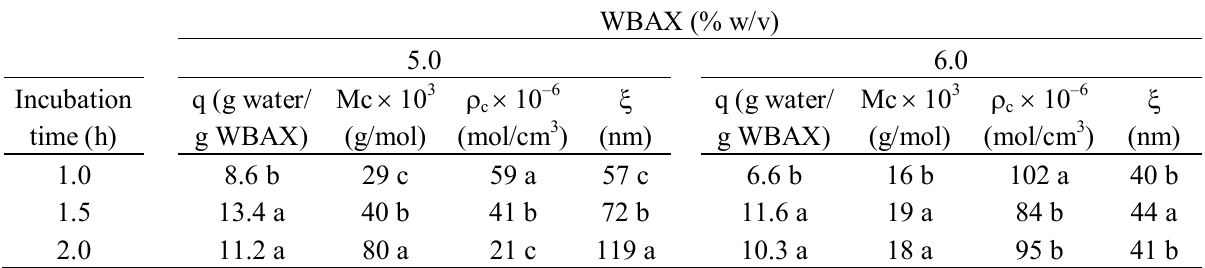
Table 2. Structural characteristics of WBAX gels formed at different polysaccharide concentrations and with distinct incubation times during WBAX